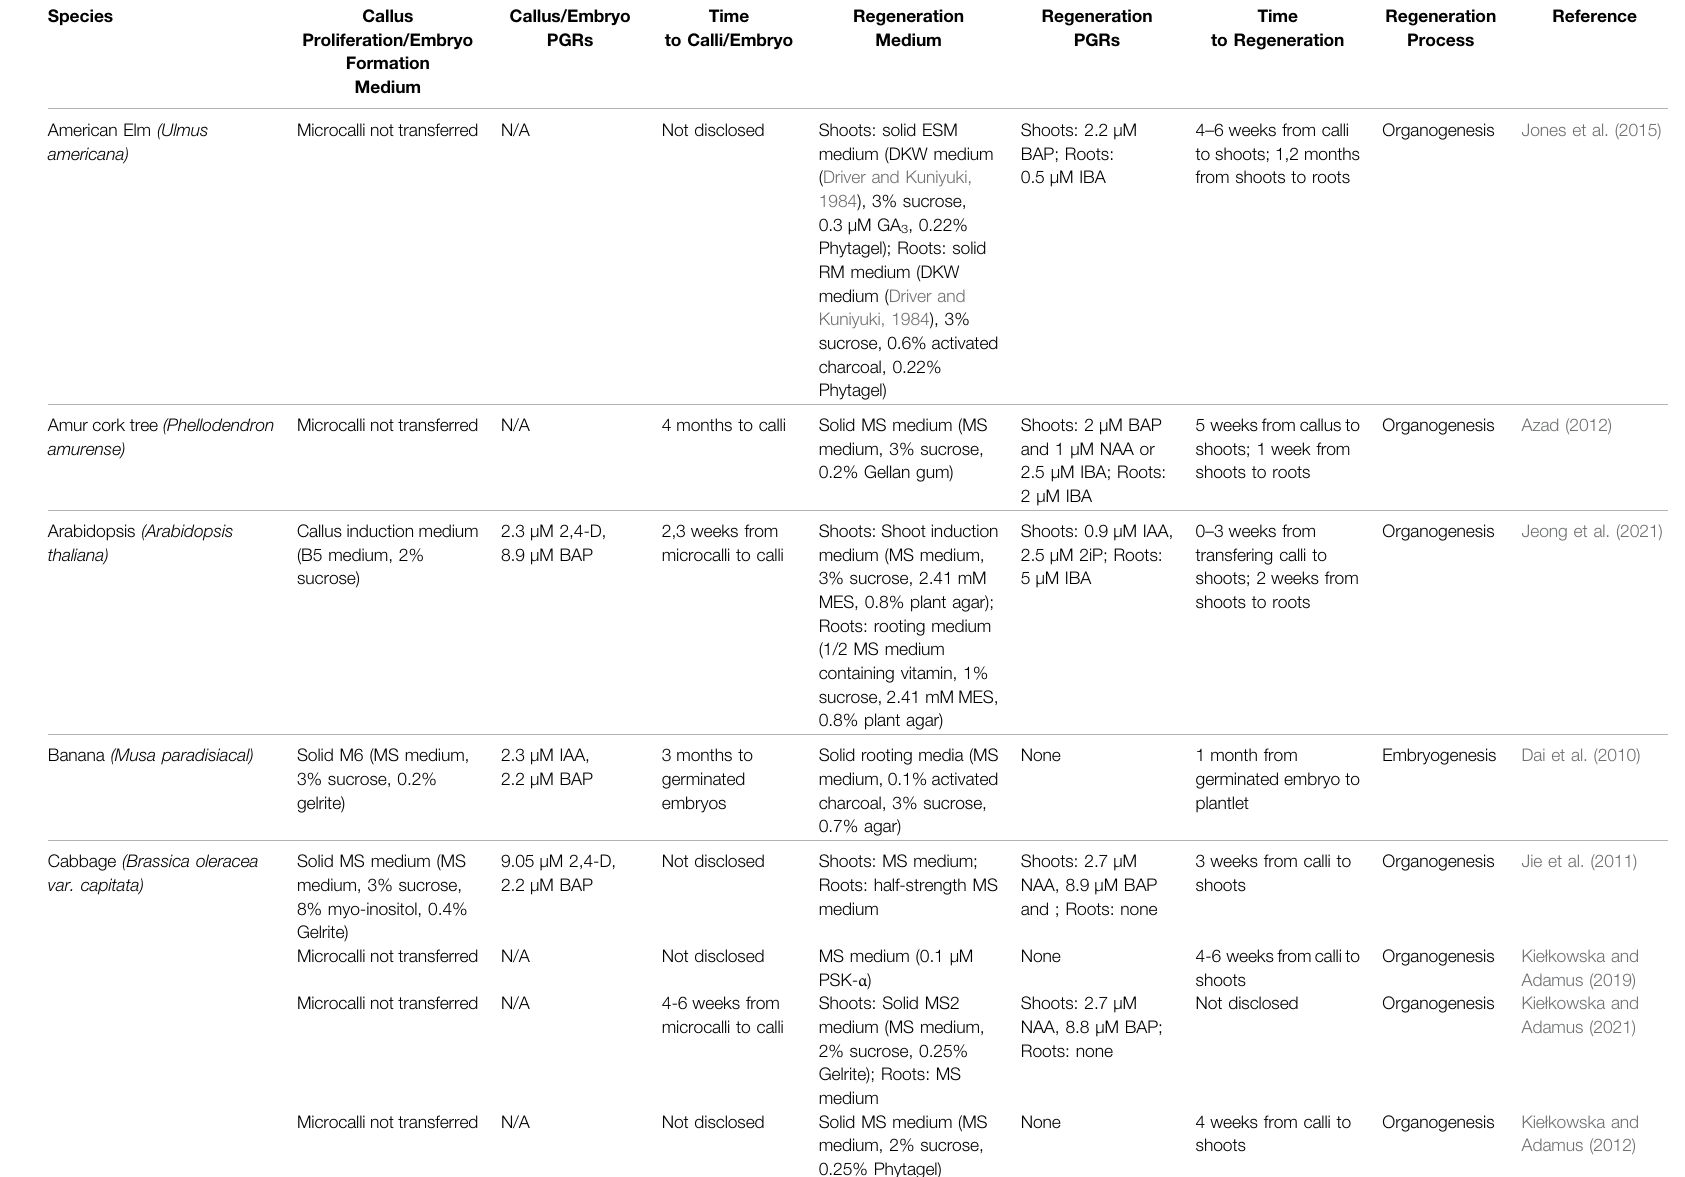
TABLE 3 | Regeneration from Protoplast